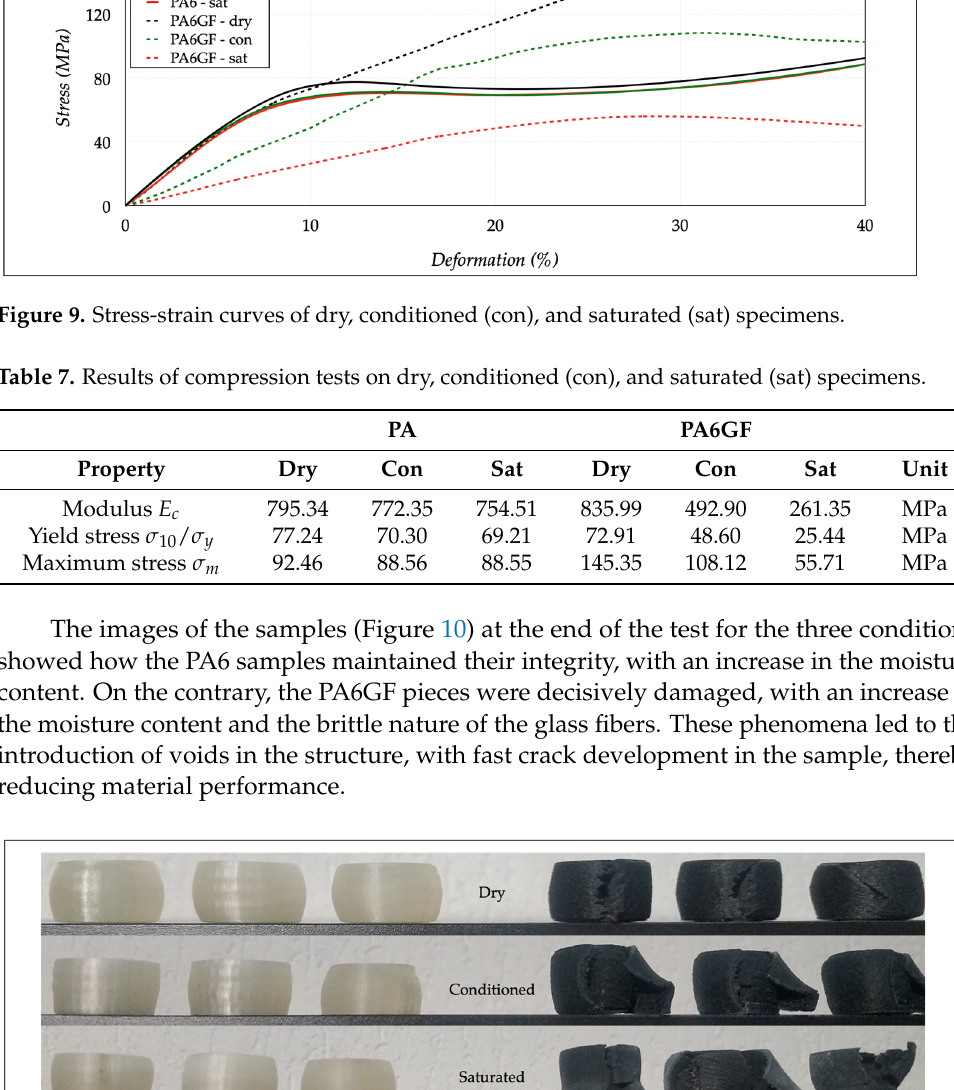
Figure 11. Sections of the printed samples (PA6 on the left side and PA6GF on the right side). 4. Conclusions The effect of moisture content on the mechanical properties of unfilled and glass fiber reinforced PA6 was studied. The moisture content increased with immersion time in a controlled bath, reaching the saturation state 5 h after the first immersion. The moisture absorption caused an increase in the dimensional variation of the printed specimens. Moreover, the results showed limited effects on the mechanical properties of the unfilled PA6, with a reduction of about 5%. A significant impact was instead detected for the PA6GF, with a decrease of the dimensional and mechanical performance in the saturated state. Moreover, the integrity of the specimens at the end of the mechanical test was com- promised, with severe cracks on the external and internal surfaces. The performance deg- radation of the PA6GF samples was 33% (yield stress) and 65% (maximum stress). This